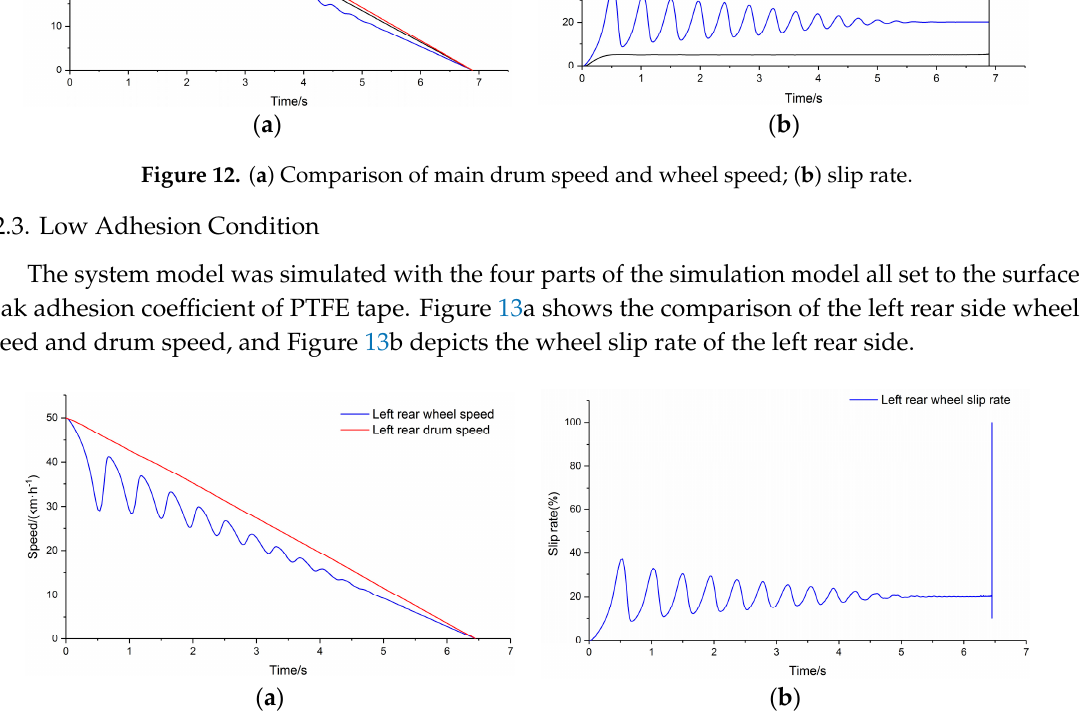
Figure 13. ( a ) Comparison of main drum speed and wheel speed; ( b ) slip rate.